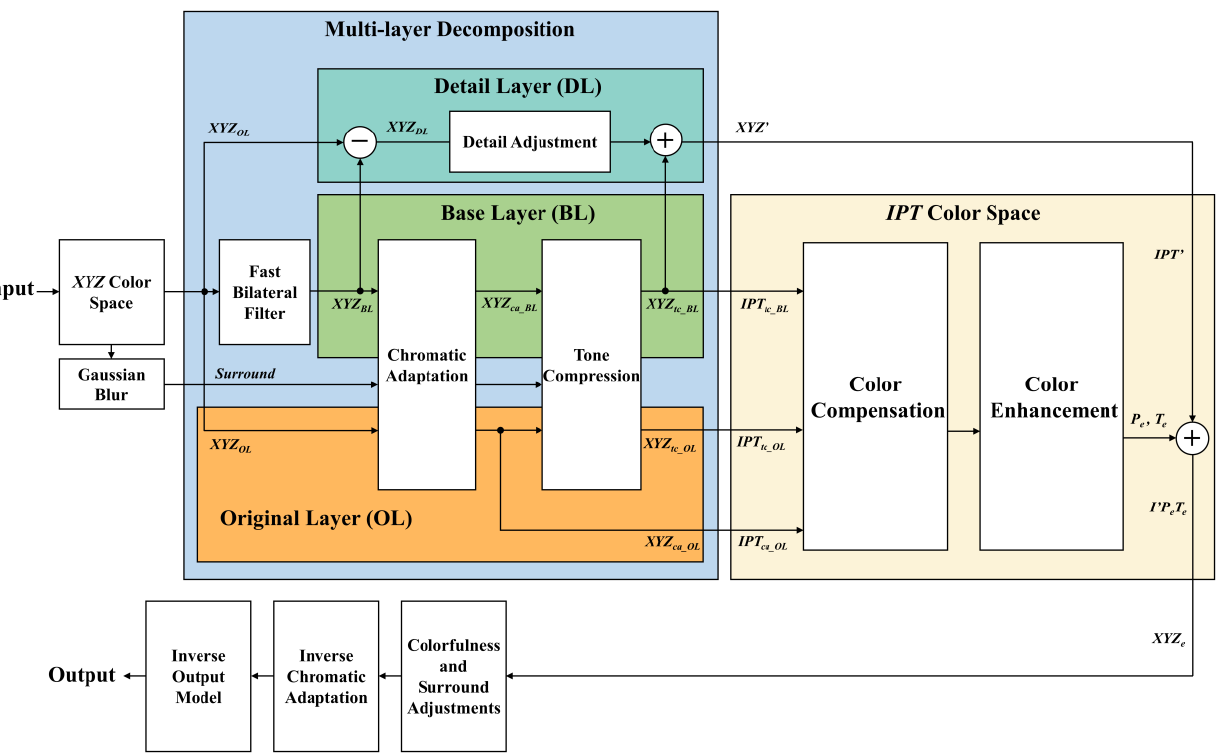
Figure 2. Flow chart of the proposed